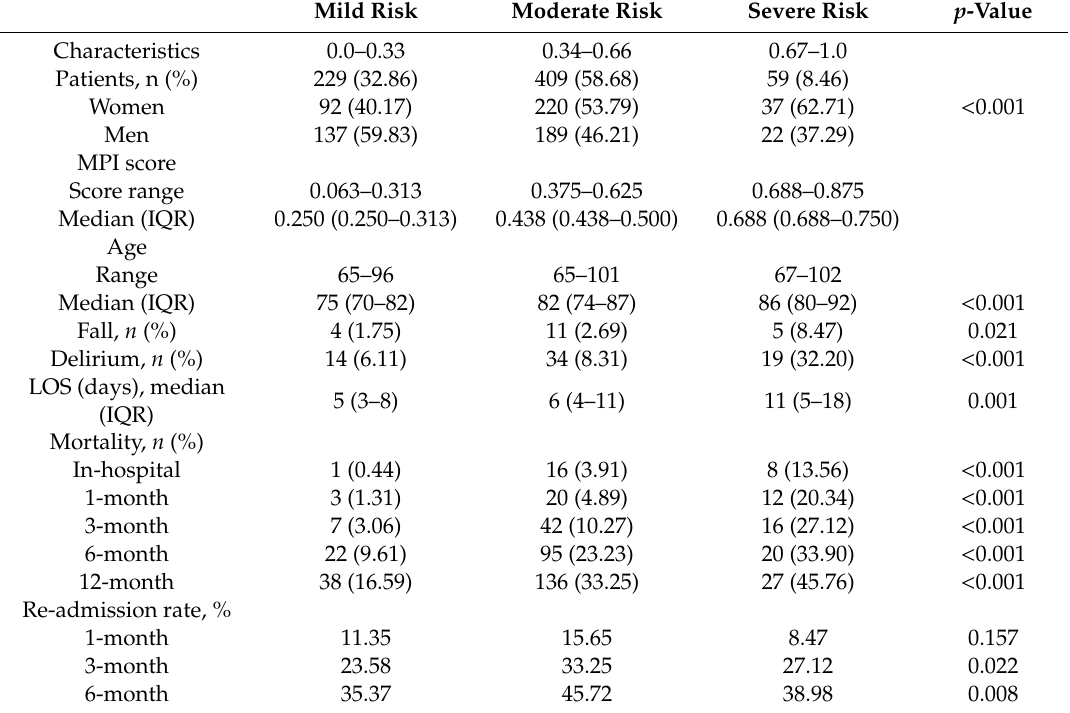
Table 1. Patient characteristics according to MPI